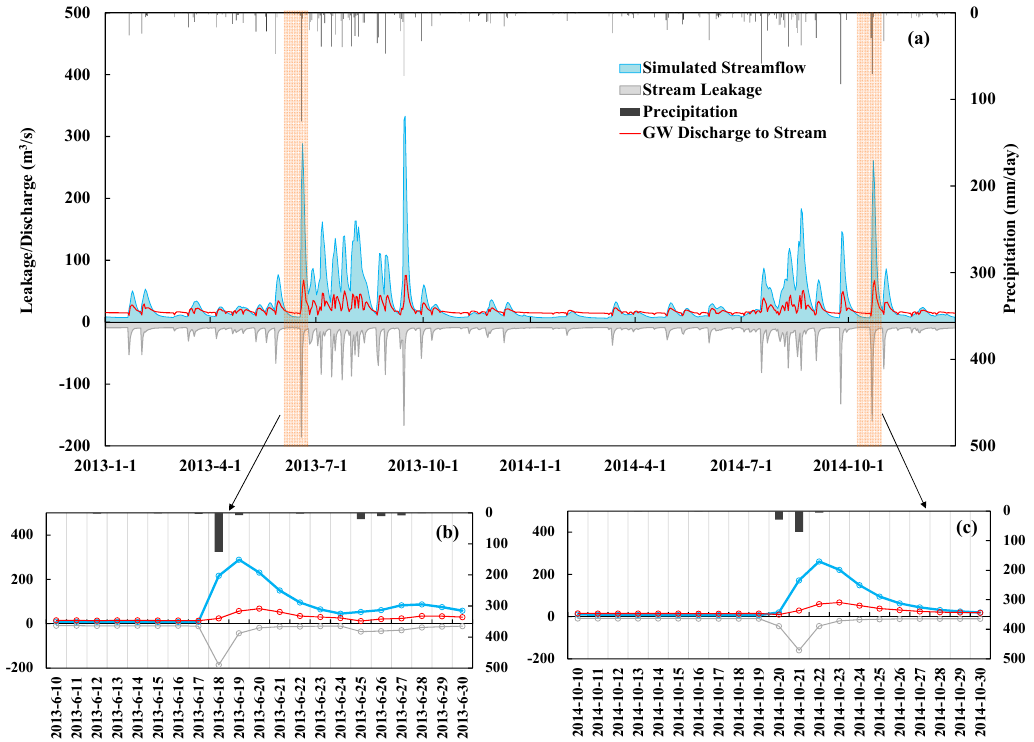
Figure 16. Daily time series of simulated hydrography at the outlet, stream leakage to groundwater (GW), and GW discharge to stream. Note that negative values indicate stream recharges to GW.